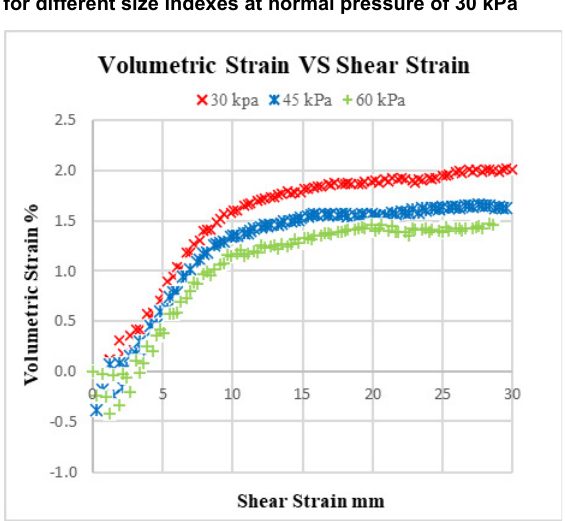
Figure 8 Volumetric strain for different size index values at a normal stress of 3 and